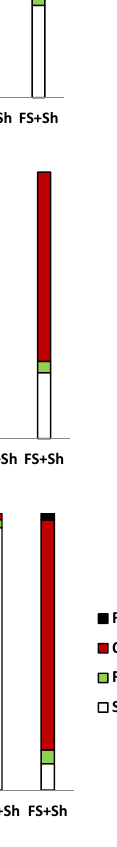
Figure 4. Percentages of the various fractions of chromium sorbed after the addition of 100mgL − 1 Cr at time 0, and taken after 24h (a) , 1 week (b) , and 1 month (c) of incubation. GM: granitic material; FS: forest soil; PM: pyritic material; Sh: mussel shell. Mean values; triplicate samples with coefficient of variation